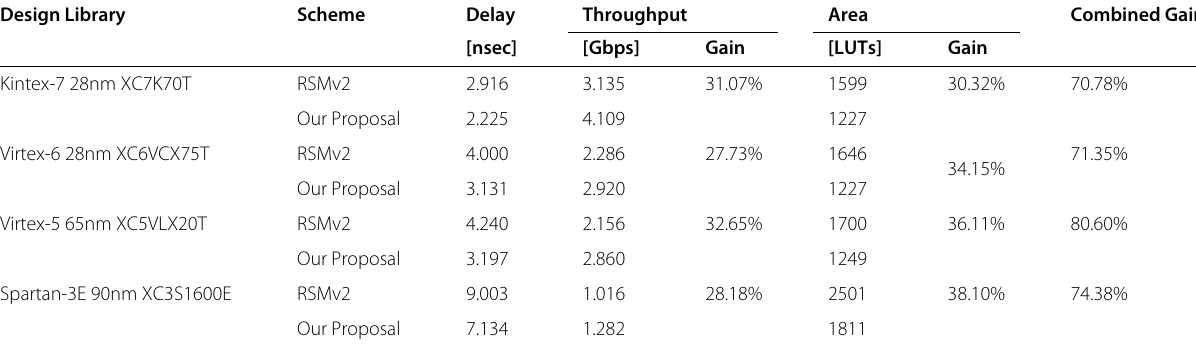
Table 6 Comparison on different hardware implementations for RSMv2 and our proposal Design